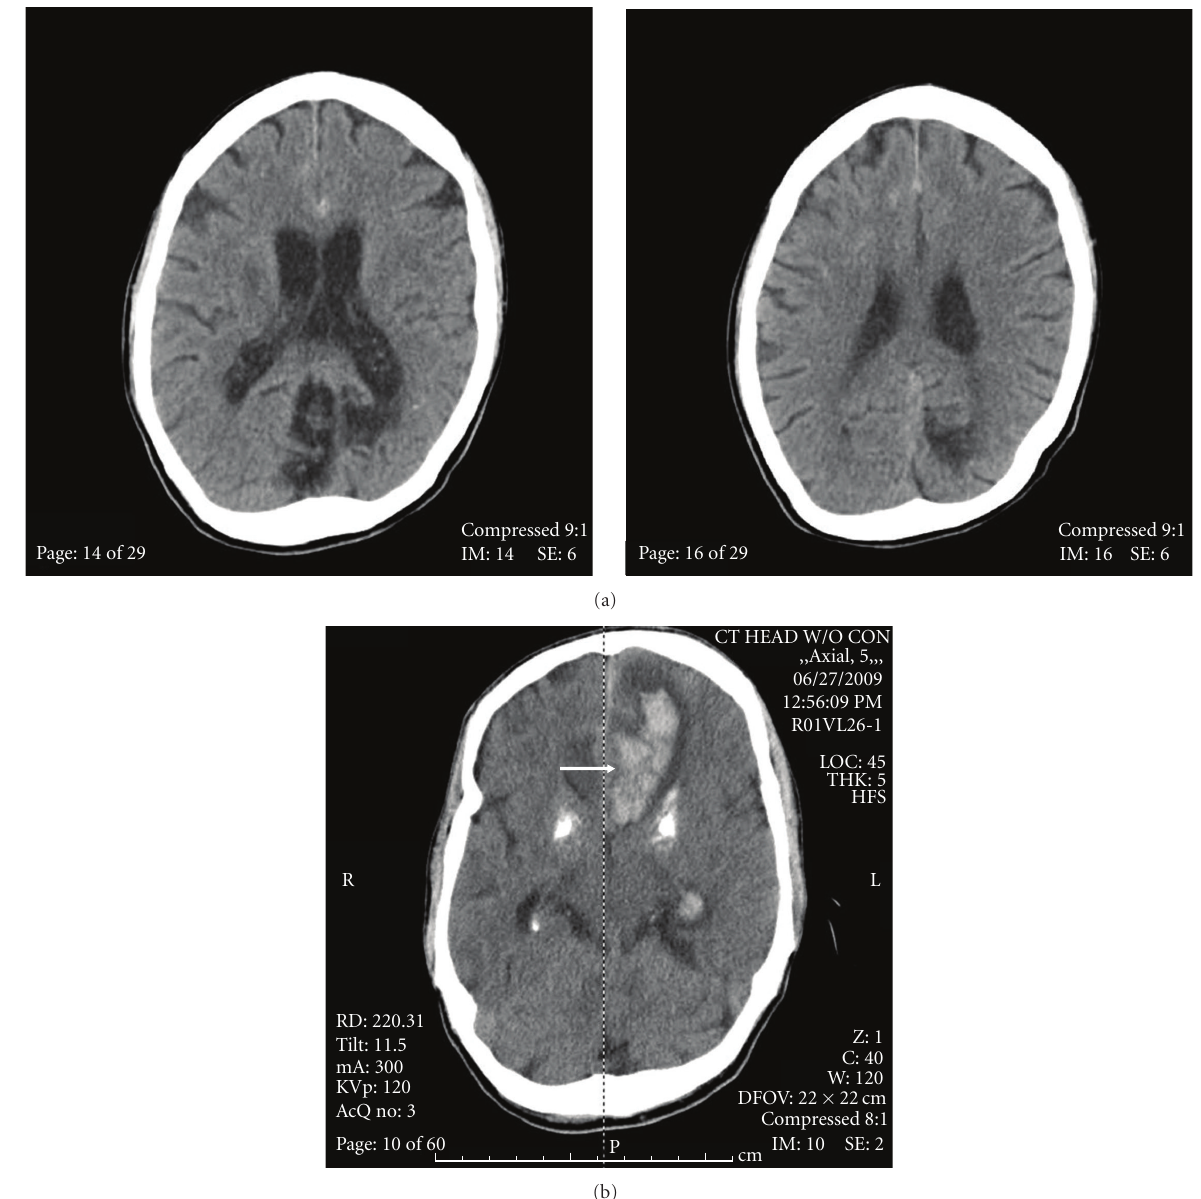
Figure 3: Progression of the ruptured Mycotic Aneurysm: (a) initial subarachnoid hemorrhage after 6 days IV antibiotics. Note interhemispheric hemorrhage. (b) Repeat noncontrast CT Brain 12 hours later, intraparenchymal hemorrhage is marked by arrow. Note prominent basal ganglia